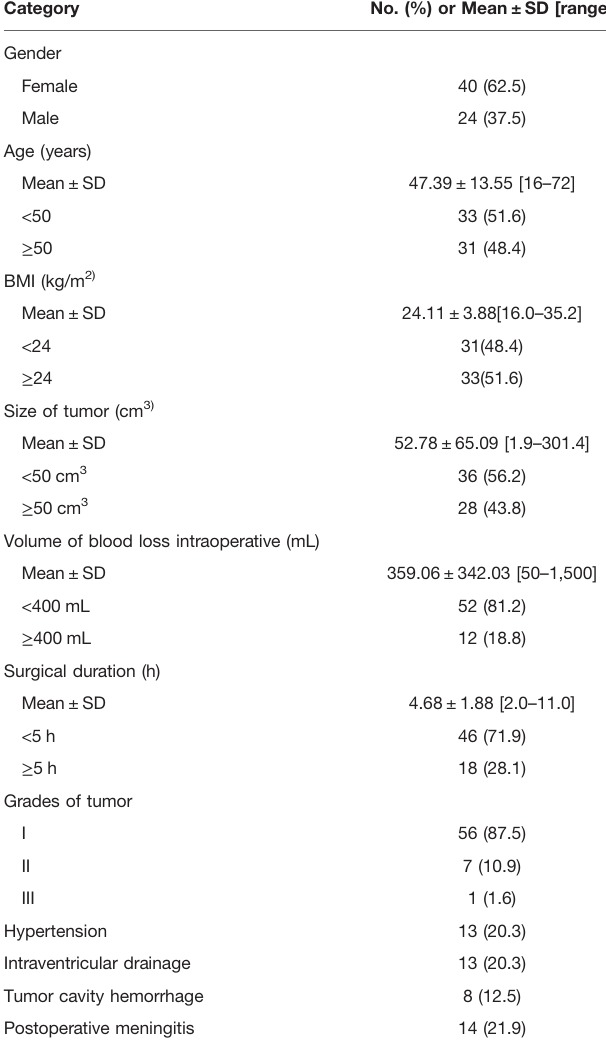
TABLE 1 | The clinical characteristics of the 64 patients with LVTMs.